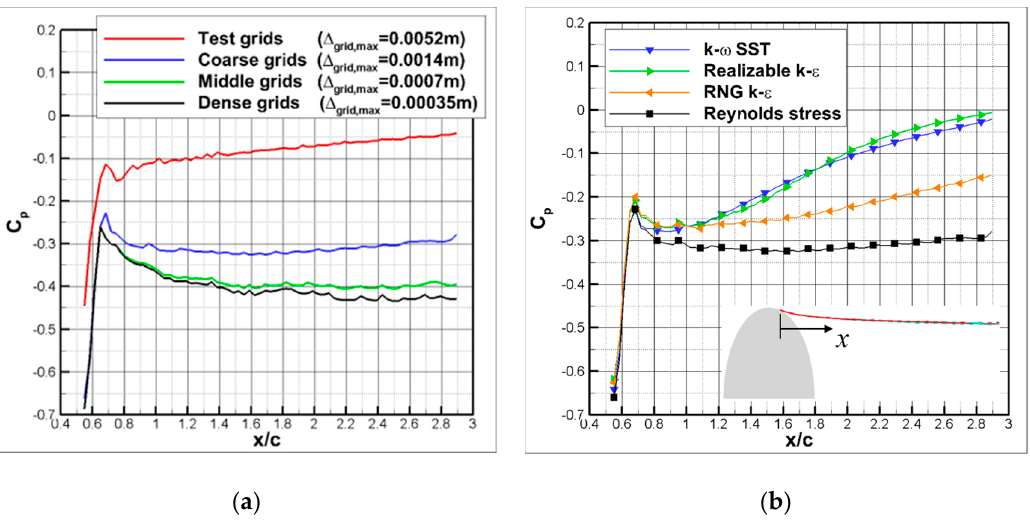
Figure 16. Variation of pressure coefficient along the vortex core line according to ( a ) grid types and ( b ) turbulence models. Grids types are varied with the Reynolds stress model and the turbulence models are varied with the coarse grids.